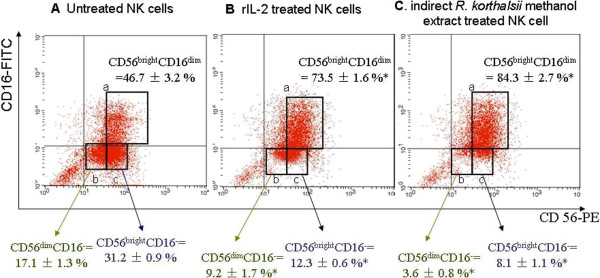
Flow cytometry analysis of CD56 and CD16 expression of NK cells isolated from treated and non-treated PBMC by using immunomagnetic negative selection NK cell isolation kit (Milteny Biotech, Germany). Gradual increased of NK cells co-expressed the CD56bright and CD16dim were observed in A to C. A. Untreated NK cells, B. rIL-2 treated NK cells, C. indirect R. korthalsii methanol extract treated NK cell. Values (n = 9; 3 independent experiments with 3 technical replicates each) represent the means ± S.E.M. * Significant (P < 0.05).